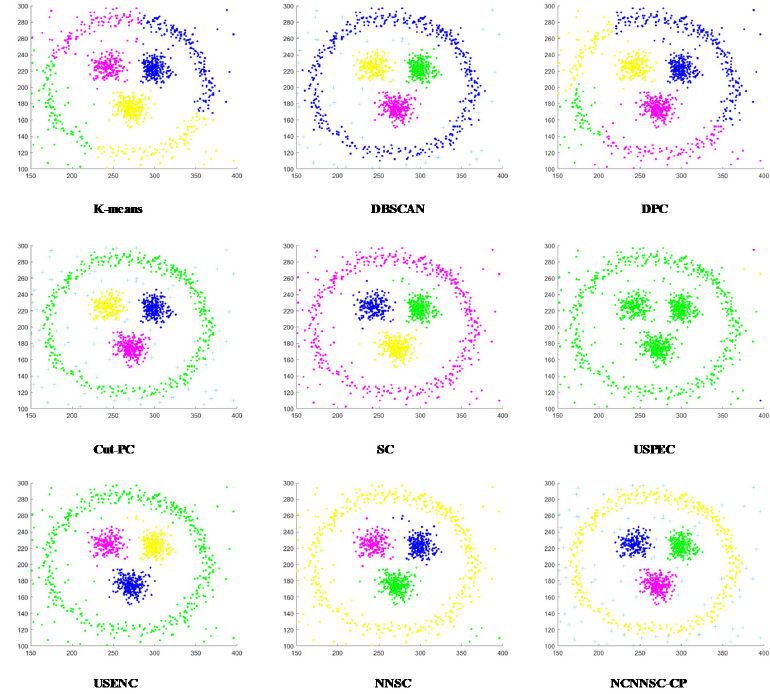
Figure 10. The results of 9 clustering algorithms in D5.